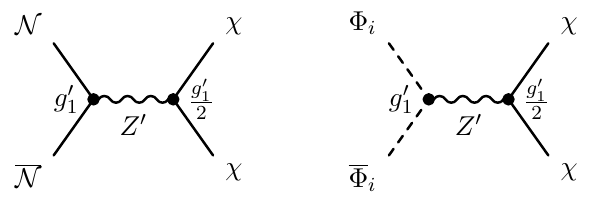
Figure 2 . The processes responsible for DM